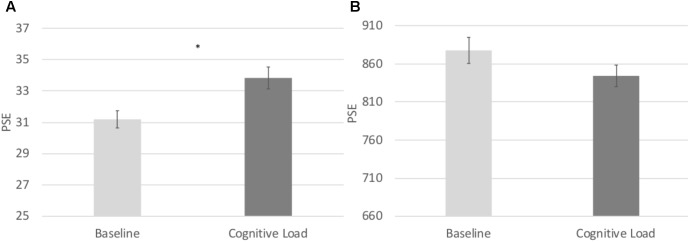
(A) Point of subjective equality estimates from the Numerical Bisection Task. (B) Point of subjective equality estimates from the Temporal Bisection Task.